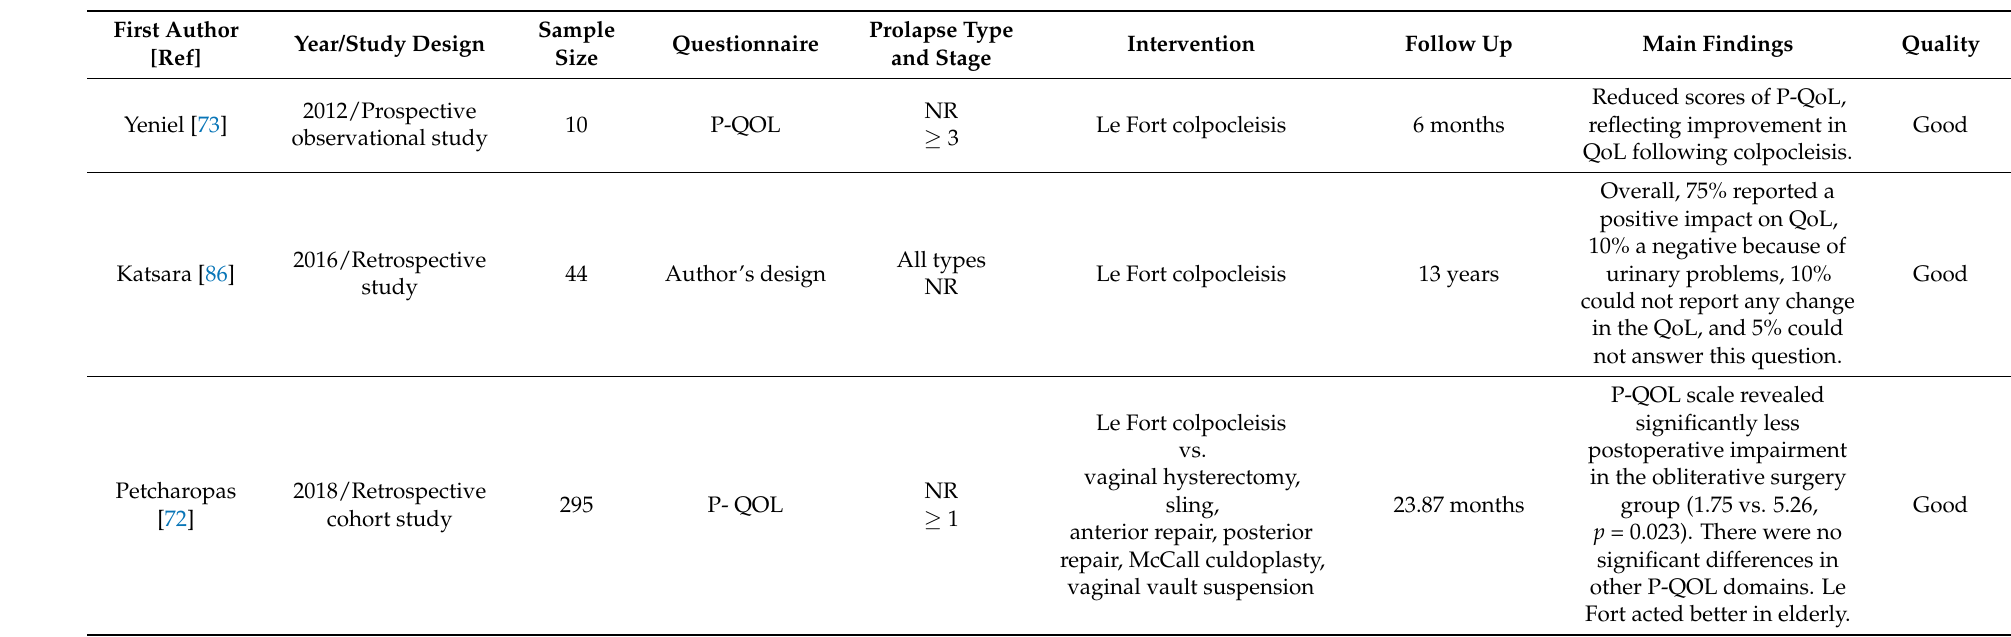
Table 4. The characteristics of the studies on the effectiveness of obliterative vaginal surgeries on the quality of life in women with pelvic organ